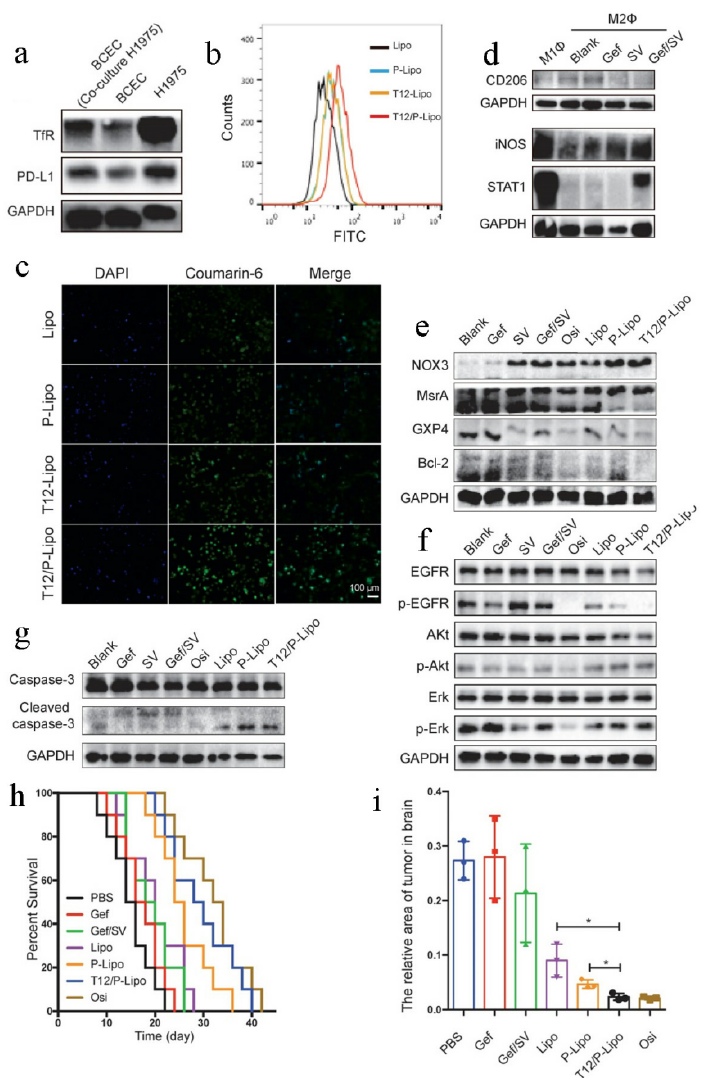
Figure 7. T12/P ‐ Lipo for overcoming cancer drug resistance and brain metastases. Reprinted with permission from Ref. [215]. 2020, NIH. ( a ) The targeting receptors in BCECs. ( b ) Uptake of T12/P ‐ Lipo by H1975 cells. ( c ) Fluorescence images of T12/P ‐ Lipo in H1975 cells. ( d ) Macrophage repolarization from M2 to M1. ( e ) The level of NOX3/MsrA/GPX4/Bcl ‐ 2 in H1975 cells. ( f ) The level of phosphorylated EGFR/p ‐ Akt/p ‐ Erk. ( g ) The level of cleaved caspase 3. ( h ) The survival curves. ( i ) Tumor regression after treatment with T12/P ‐ Lipo. * p < 0.05.